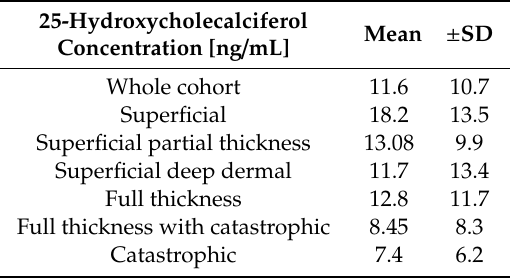
Table 3. 25-hydroxycholecalciferol concentration according to burn